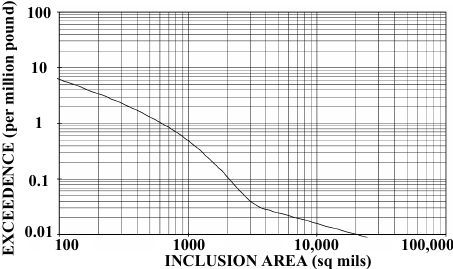
Figure 2. Initial defect distribution curve of hard α defects [7].